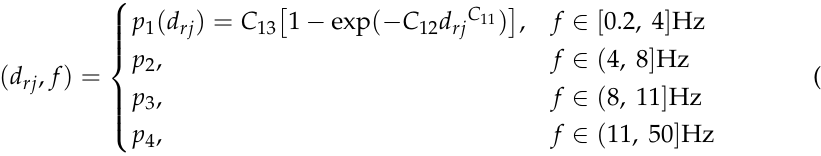
separation distance. The negative-time spectra in different earthquake groups are averaged and drawn in gray lines in Figure 12.